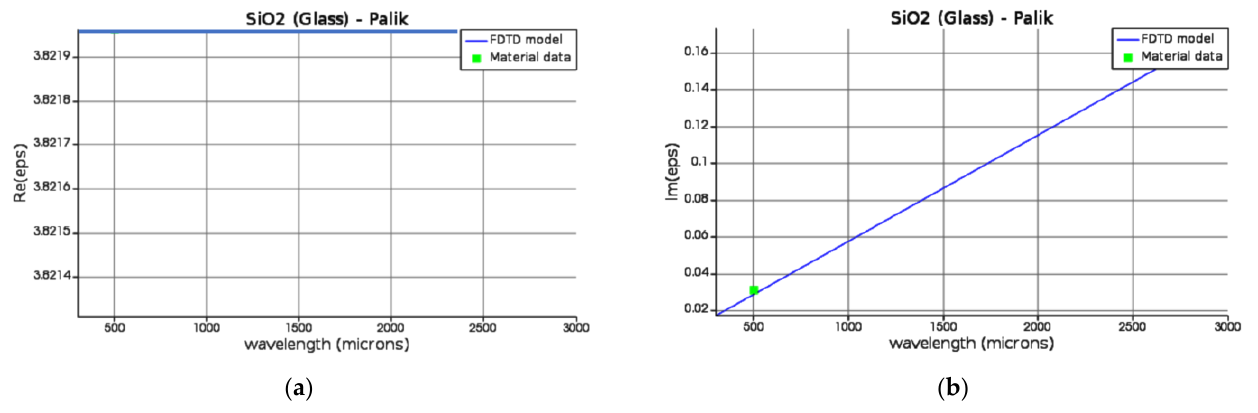
Figure A1. Dielectric constant of Al 2 O 3 : ( a ) The real part of the dielectric constant; ( b ) The imaginary part of the dielectric constant.